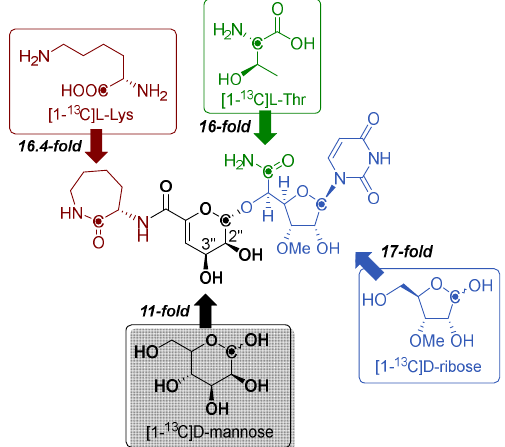
Figure 3. Metabolic origin of A-500359s and A-503083s as determined through feeding experiments using the indicated isotopically labeled precursors.